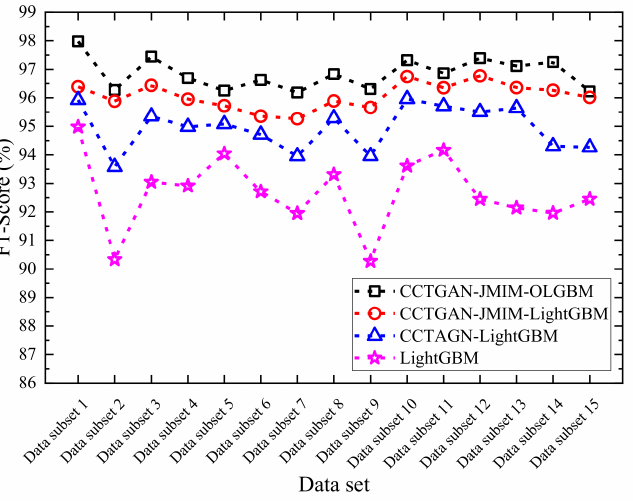
Figure 15. Comparison of model performance in each optimization stage of the proposed